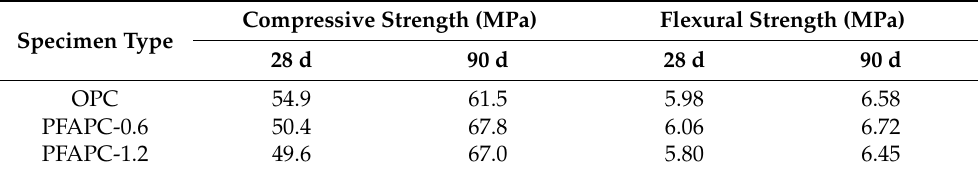
Table 4. Static mechanical properties of airport pavement concrete.